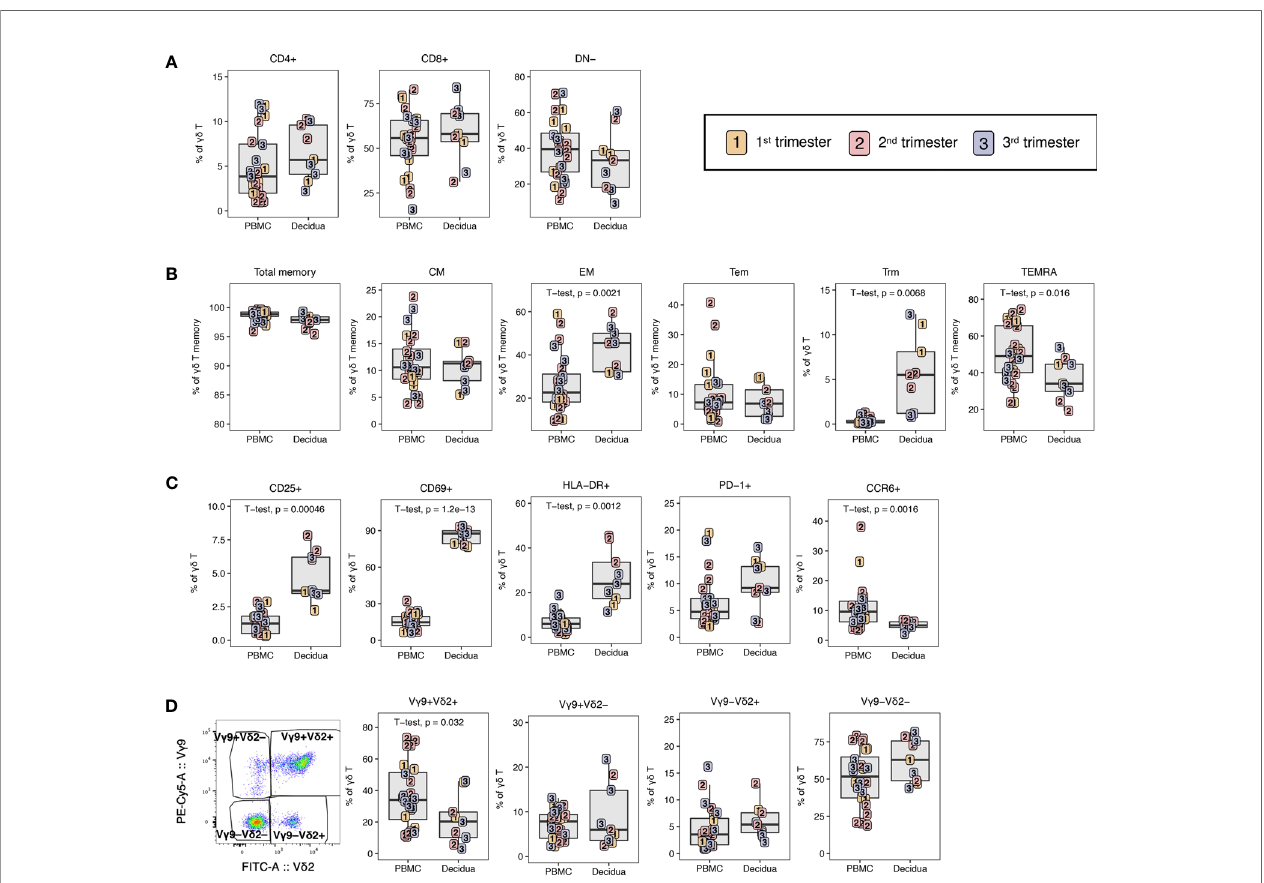
FIGURE 6 | gd T lymphocytes in PBMC and decidua of normal rhesus macaque pregnancies. (A) CD4 and CD8 expression on gd T lymphocytes in PBMC and decidua in fi rst (yellow), second (red) and third trimester (blue) of pregnancy of normal rhesus macaques. (B) Memory phenotype of gd T lymphocytes. (C) Phenotype of activation, exhaustion, cytotoxic potential and chemokine receptor expression in gd T lymphocytes. (D) Representative fl ow plot of V g 9 and V d 2 chains and the V g 9 and V d 2 subsets in PBMC and decidua. P-values < 0.05 (unpaired t-test) shown on the